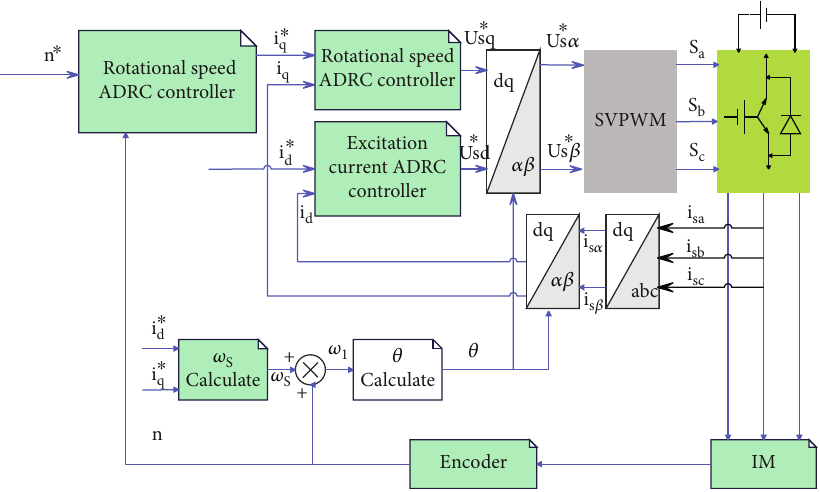
Figure 4: Induction motor vector control system based on active disturbance rejection control. observer. A fi rst-order ADRC control of the speed loop is considered, and its structure is shown in Figure 3.